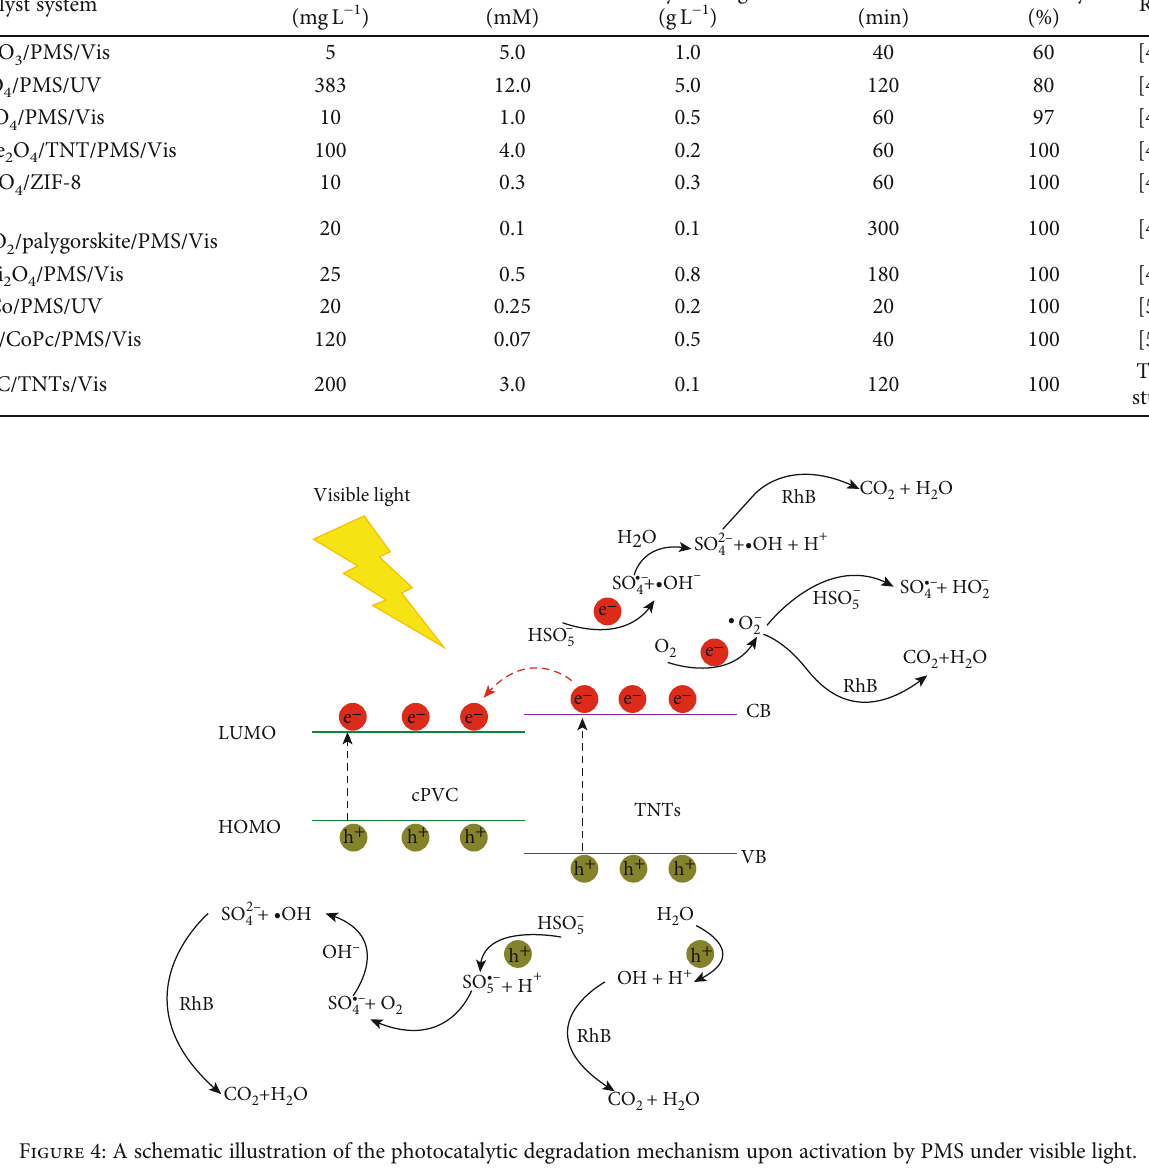
Table 1: A comparison of photocatalytic activity against RhB between current systems having been assisted by PMS activation. Pollutant conc. Catalyst system